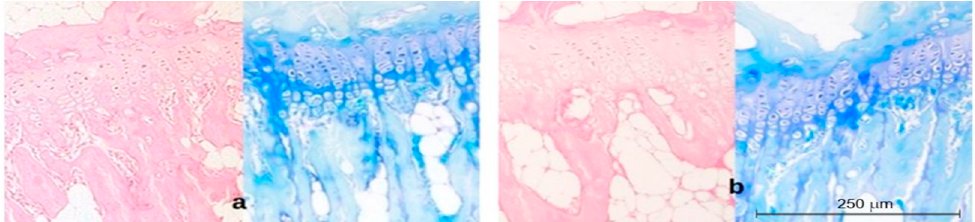
Figure 3. Histopathological image of cartilage in the control group of 52-day-old animals (day of the start of the experiment) (group I) ( a ) and the control group of 94-day-old animals (day of the end of the experiment) (group III) ( b ). H&E and Methyl Blue staining 200×.